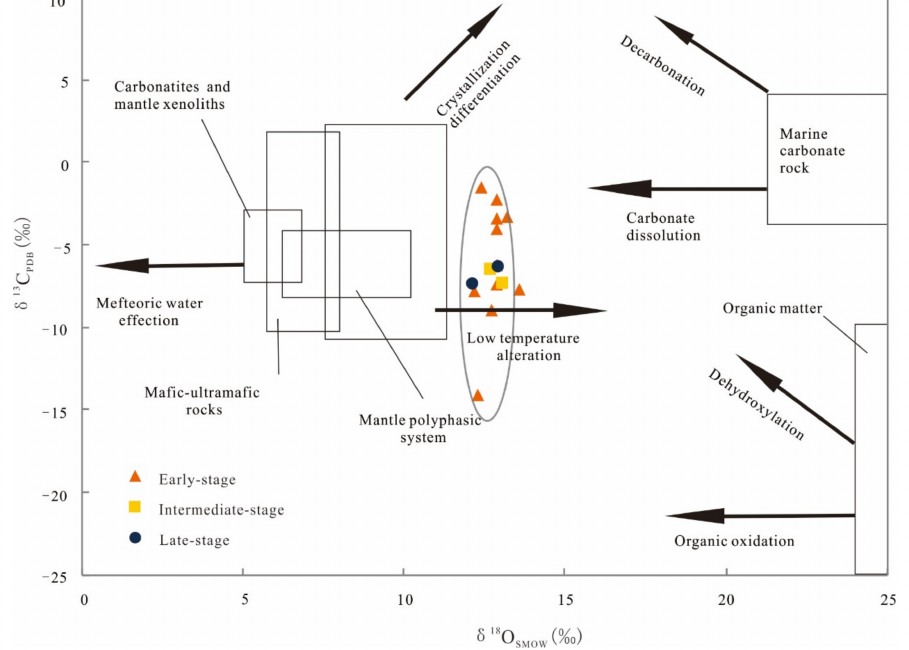
Figure 9. Plot of δ 13 C PDB for fluid inclusions in quartz versus δ 18 O SMOW for the quartz from the Juyuan tungsten deposit. Data for the C-O reservoirs and geological processes reasonable for the C-O isolate variations were obtained from